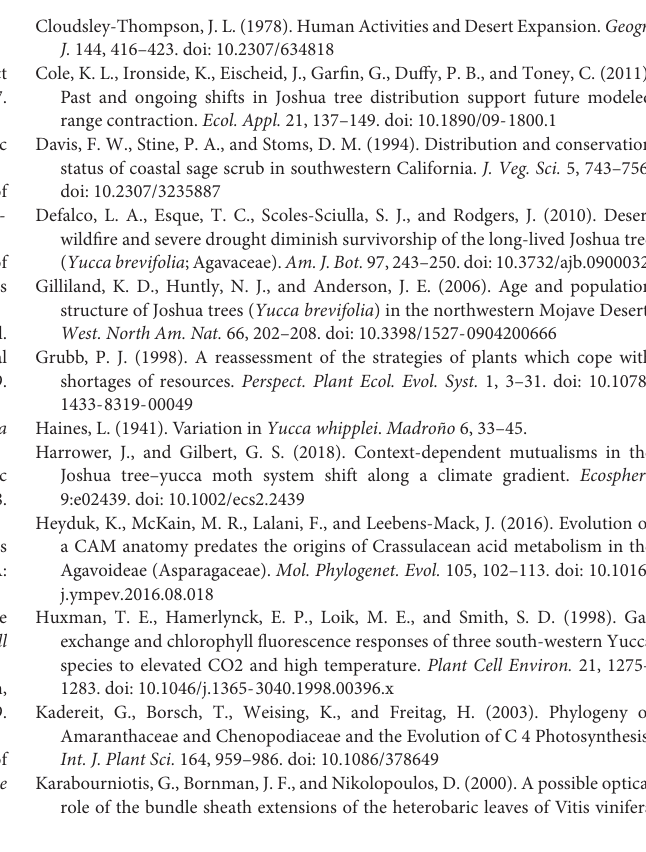
Supplementary Figure 1 | Testing for an effect of time of measurement on stomatal conductance in Y. brevifolia (A–C) and H. whipplei (D–F) growing in different micro-habitats in the West Mojave Desert. SE, south-eastern slope, AF, alluvial fan, and NW, north-western slope. n = 23–25 leaves per species per site. The Pearson correlation coefficient and p -value are provided in each panel. Supplementary Figure 2 | Testing for an effect of vapor pressure deficit on stomatal conductance in Y. brevifolia (A–C) and H. whipplei (D–F) growing in different micro-habitats in the West Mojave Desert. SE, south-eastern slope, AF, alluvial fan, and NW, north-western slope. n = 23–25 leaves per species per site. The Pearson correlation coefficient and p -value are provided in each panel. Supplementary Figure 3 | Modeled leaf surface area. Supplementary Table 1 | Averages and raw data for the physiological and morpho-anatomical traits of the